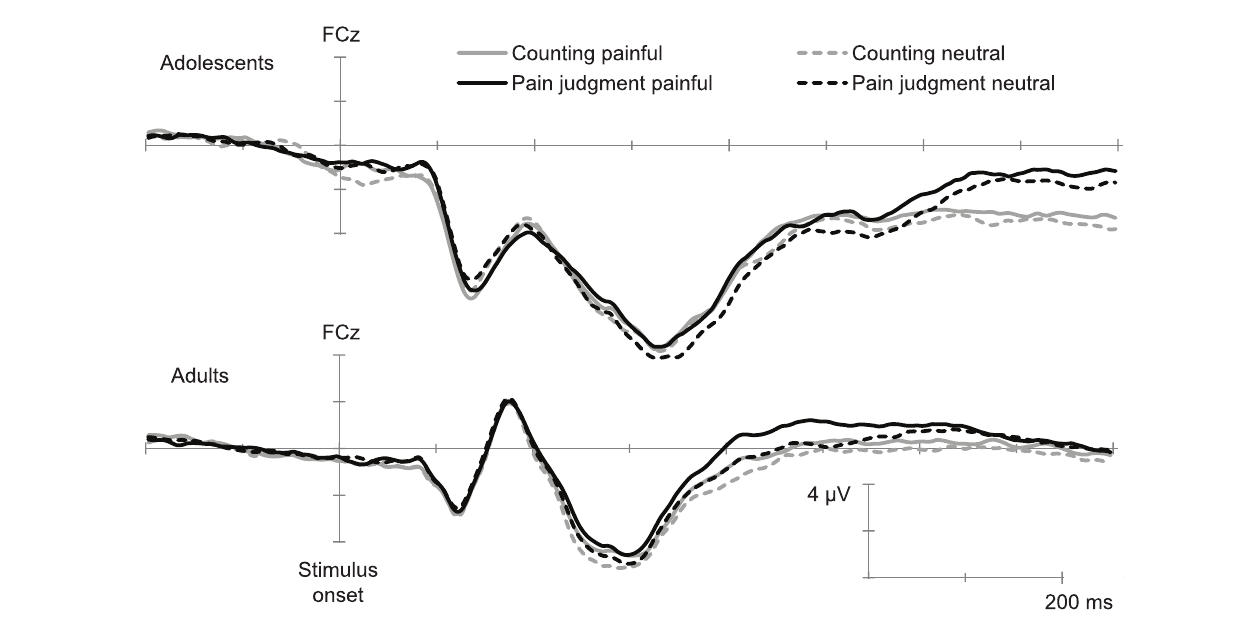
FIGURE 1 |Temporal course of early ERPs elicited by painful and non-painful pictures in the pain judgment task and in the counting task (Grand mean of 15 adults and 14 adolescents). This illustration shows the N110 and N340 recorded over